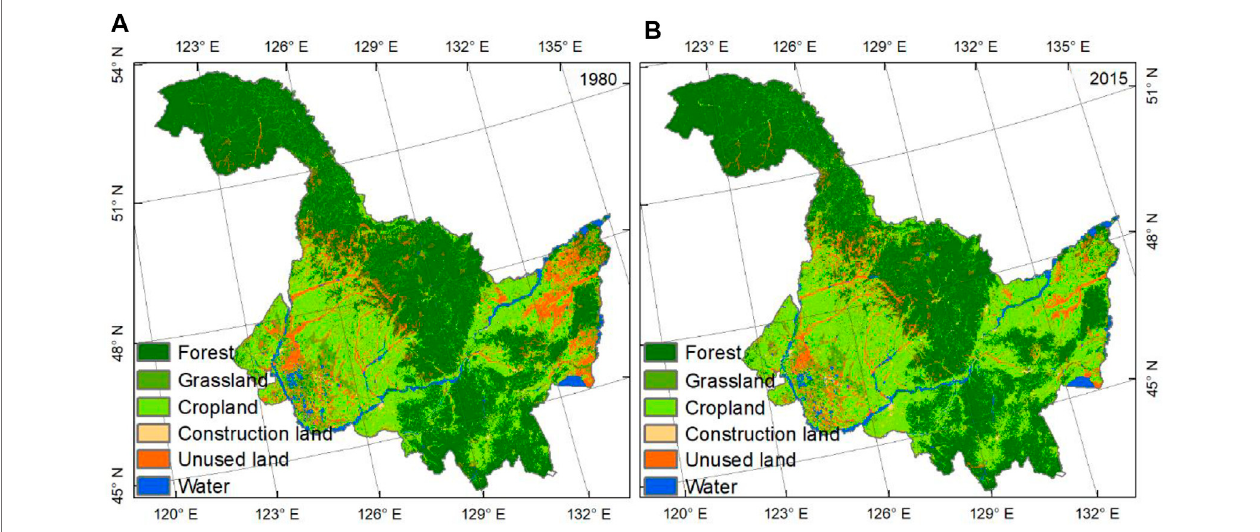
FIGURE 3 | Changes in LULC types in Heilongjiang Province, Northeast China in 1980 and 2015.